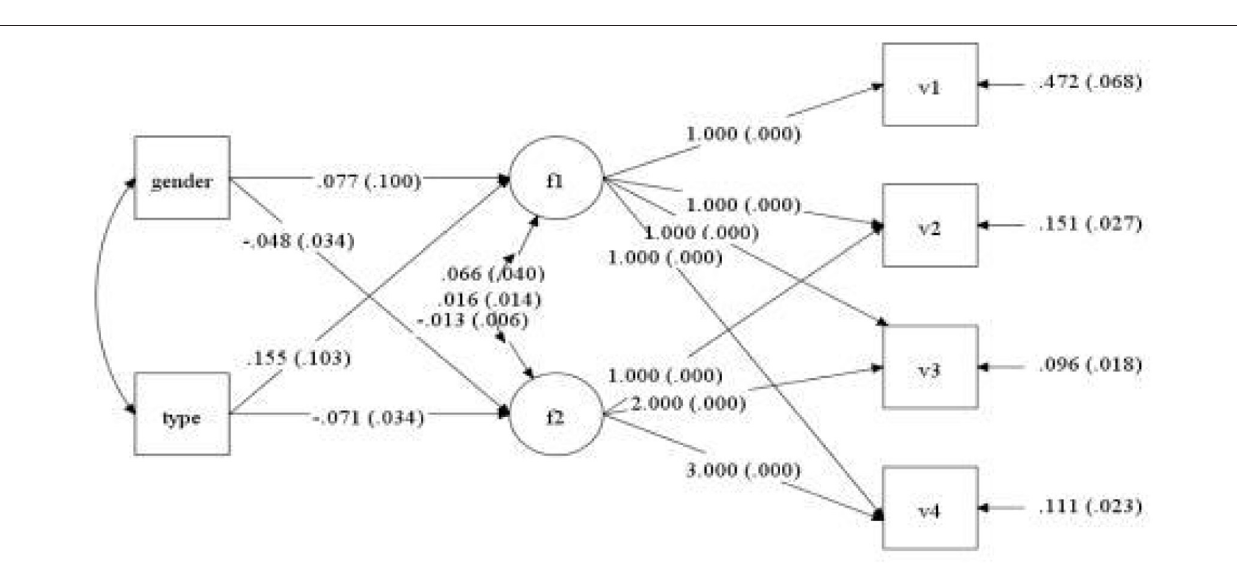
medical staff at each observation point indicated that they were